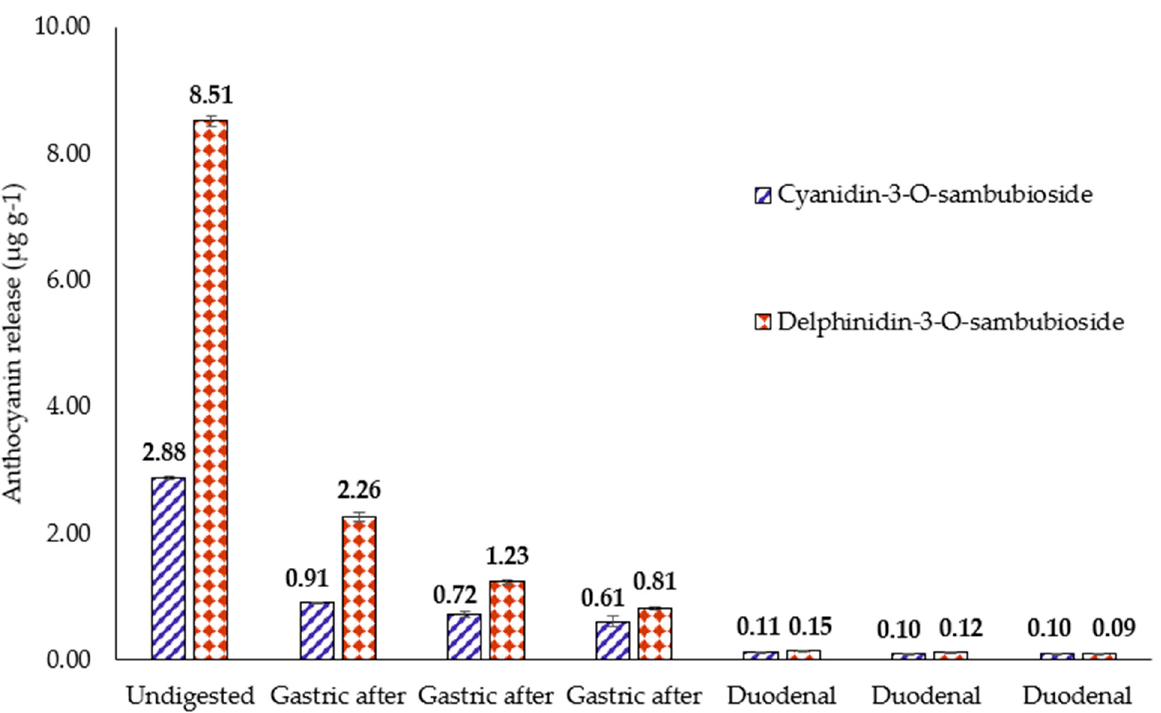
Figure 6. Quantification of anthocyanins in the raw extract and during in vitro gastric and duodenal